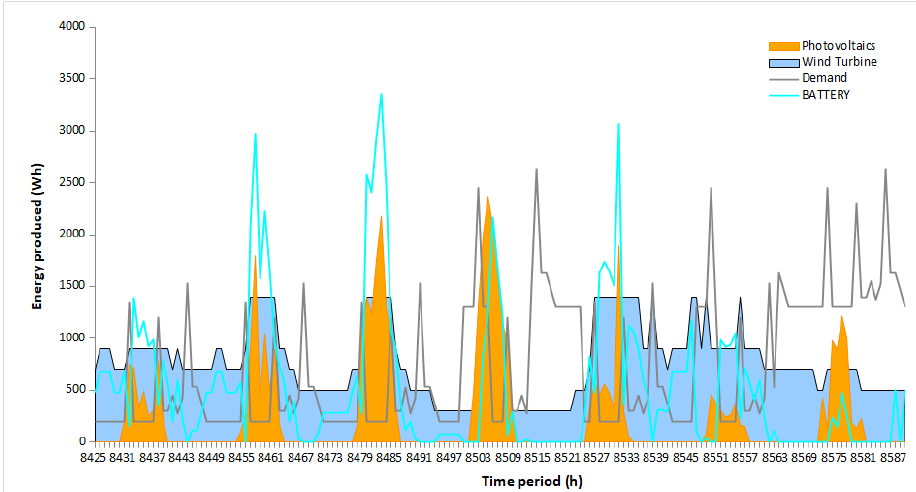
Figure 7. Energy produced by the system with batteries during December.